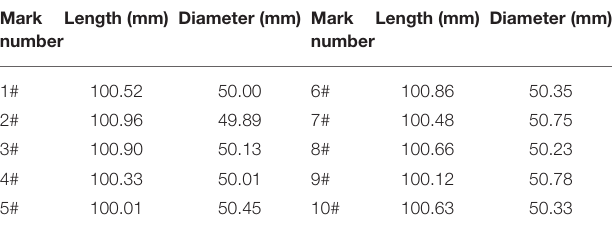
TABLE 1 | Sample parameters and